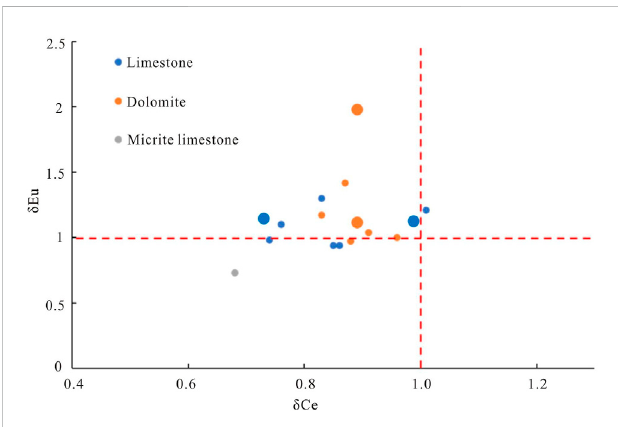
FIGURE 8 Distribution of Eu and Ce in dolomites of Permian Qixia Formation in Central Sichuan Basin (partial data from Duan et al., 2021). The enlarged symbol data comes from Duan et al.,